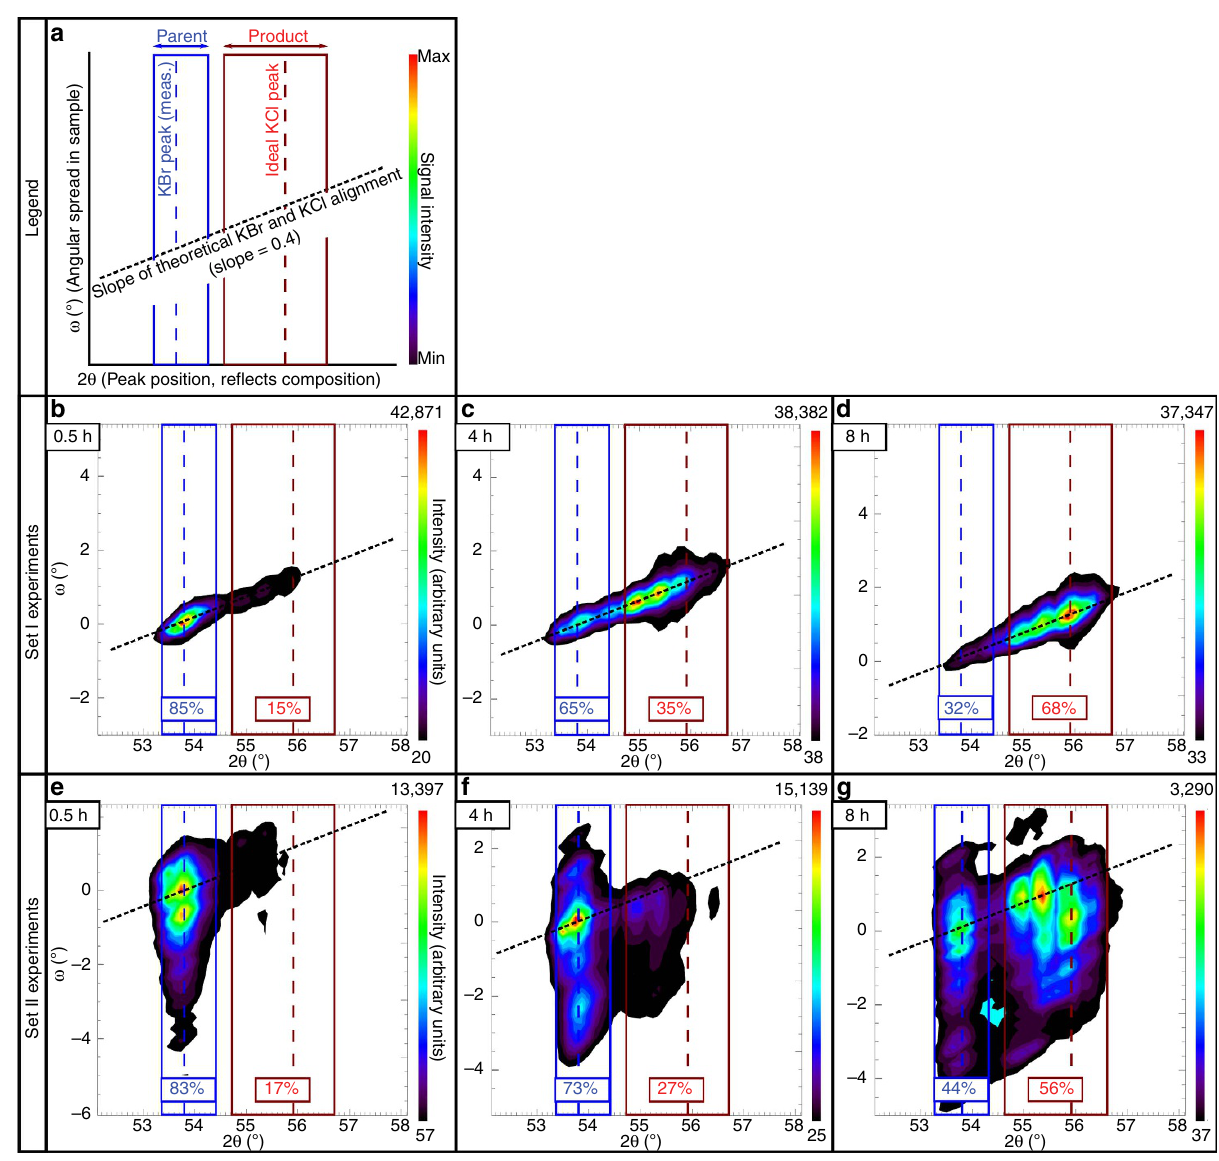
Figure 2 | Neutron diffraction data. ( a ) A legend showing the main features noted in the plots. ( b – d ) Set I samples. ( e – g ) Set II samples. The x axis (2 y ) represents lattice parameters in the analysed samples, the ideal positions for KBr and KCl are marked with dashed vertical lines and the observed range for parent (KBr) and product (KBr-KCl) reflections are marked with blue and red boxes. The y axis (sample o ) represents angular spread ( (cid:2) ) in the samples relative to the parent reflection peak. The o –2 y gradient describes positions where parents and products are in an ideal crystallographic alignment. The mode% of the parents and products are measured and calculated from BSE images of the cross-sections of reacted samples before neutron diffraction